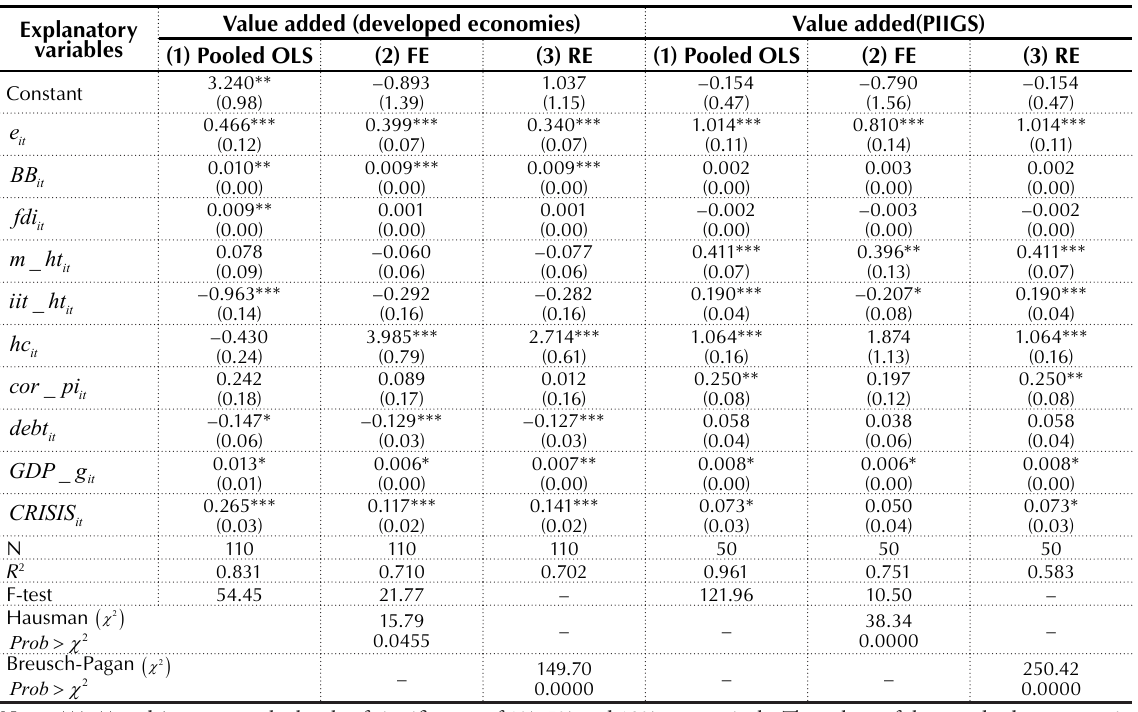
Table 5b. Value added determinants: developed economies and PIIGS Source: Authors’ calculations based on data from the sources mentioned in Table